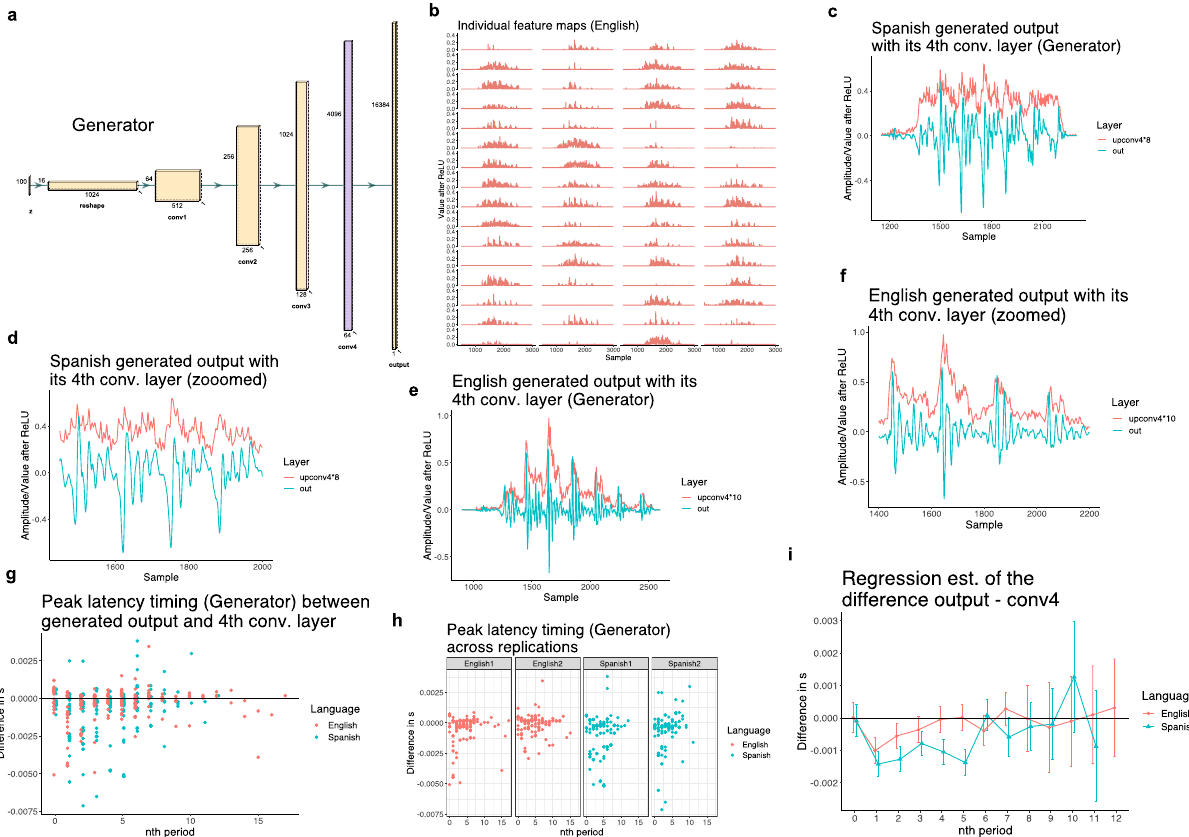
Figure 4. ( a ) The structure of the Generator network with five convolutional layers 66 . The fourth convolutional layer (Conv4; second to last) is color-coded with purple. ( b ) All 64 individual feature maps for a single output forced to closely resemble the stimulus from the fourth convolutional layer (Conv4) after ReLU (upsampled). ( c ) One Spanish output (in green) forced to resemble the stimulus with the corresponding values from the fourth convolutional layer (Conv4) averaged over all feature maps. The plot illustrates peak latency between output and Conv4 for the burst and each vocalic period. ( d ) A zoomed version of (c) focusing on four vocalic periods. ( e ) One English output (in green) forced to resemble the stimulus with the corresponding values from the fourth convolutional layer (Conv4) averaged over all feature maps. The plot illustrates peak latency between output and Conv4 for the burst and each vocalic period. ( f ) A zoomed version of (e) focusing on four vocalic periods. ( g ) Raw peak latency timing (output peak time - Conv4 peak time) for burst (=0) and each nth vocalic period across the two conditions (English vs. Spanish). Periods above the 12th period are rare and are discarded from the statistical analysis due to a small number of attestations. The data is pooled across the two replications. ( h ) Raw peak latency timing across the replications (first and second replication) and two conditions (English and Spanish). ( i ) Linear regression estimates for the peak latency timing between the two conditions (English vs. Spanish). Periods above the 12th period are discarded from the analysis due to a small number of attestations. The data is pooled across the two